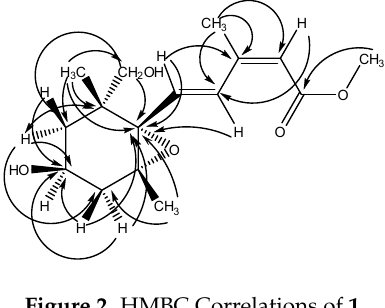
Figure 2. HMBC Correlations of 1 . Table 1. 1 H- and 13 C-NMR spectral data of 1 (CD 3 OD, 400 MHz).